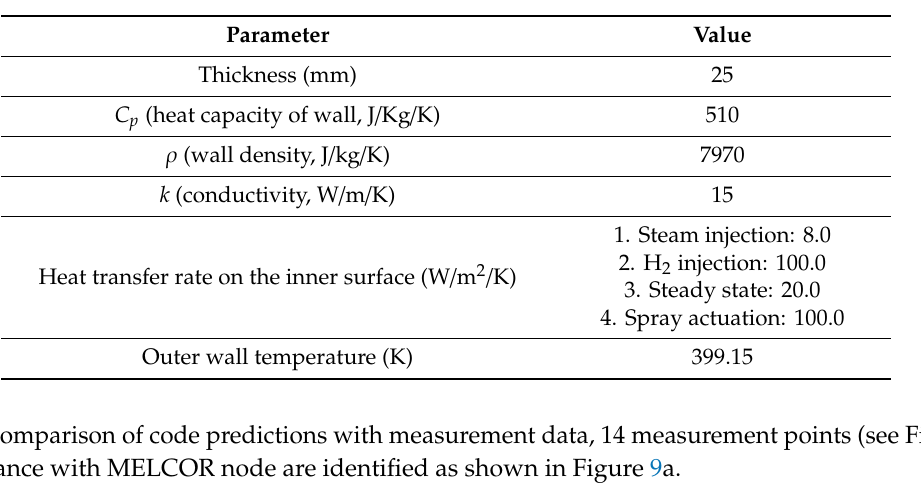
Table 6. Heat structure boundary conditions (for heat loss of outer wall of the test vessel).